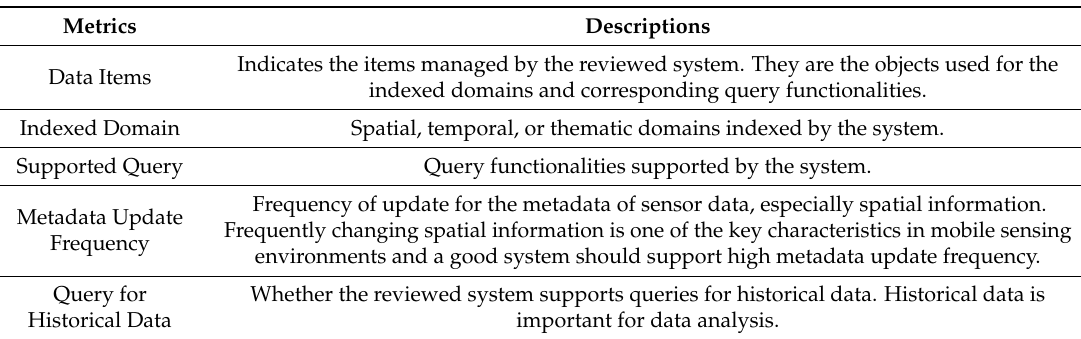
Table 1. Metrics of Indexing and